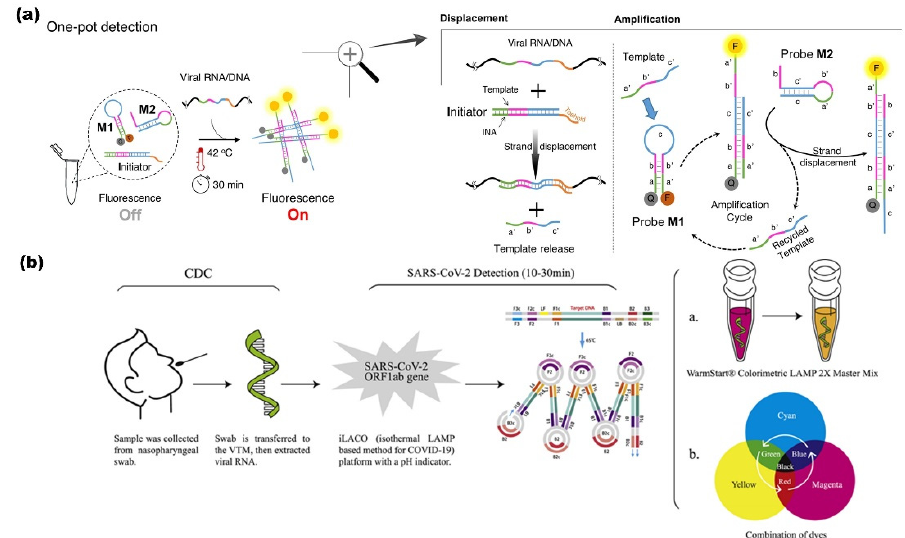
Figure 2. ( a ) NISDA assay (non-enzymatic RT-LAMP); components of reaction mixture include DNA duplex and two DNA probes (M1 and M2). Template displacement is triggered by toehold upon detecting the target, followed by a cascade of sequential amplification of the signal. Quenched 6-FAM fluorophore (bhq-1) restores fluorescence upon detecting target (viral RNA/DNA) after 30 min. at 42 °C. Letters labels represent domains, while prime labeled domains donated complementary sequences Readapted with permission [93]. Copyright © 2021, The Authors. ( b ) Colorimetric sensor based on iLACO system. I: LAMP in Master Mix II: Combining different dyes. Reproduced with permission [94]. © 2021 The Authors. Published by Elsevier Ltd.